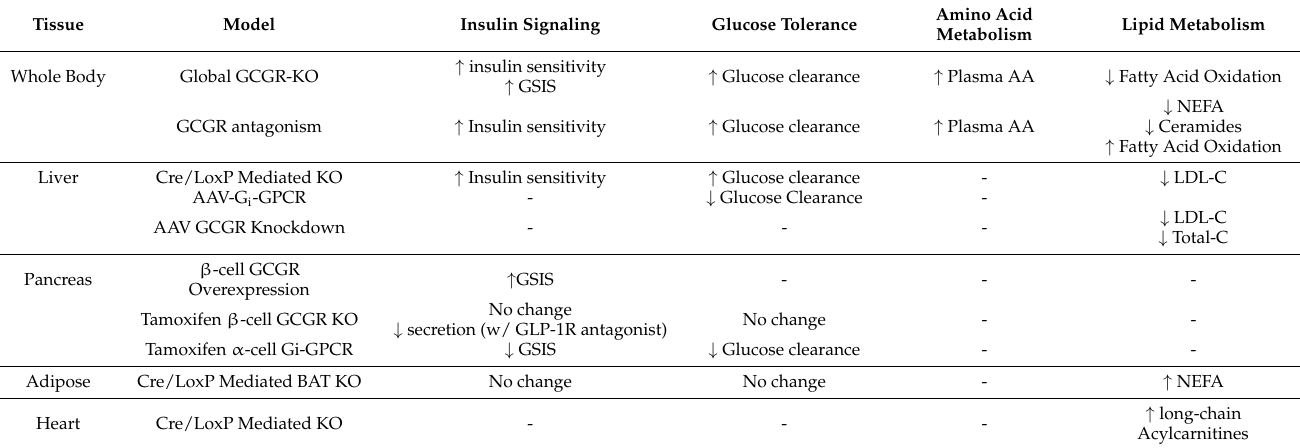
Table 1. Overview of metabolic consequences resulting from GCGR-KO at specific tissues.